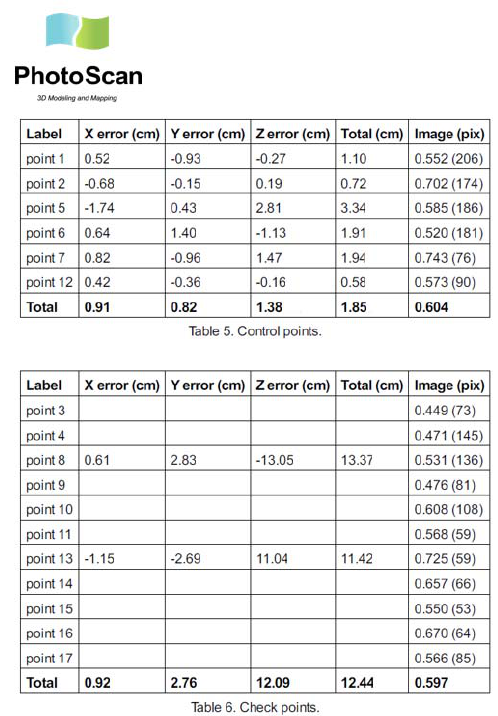
Figure 8: Error reporting